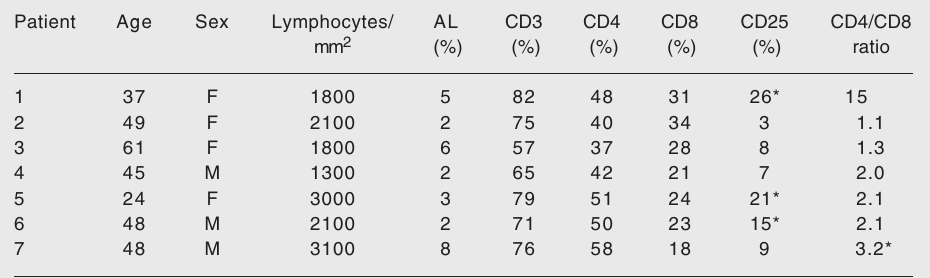
Figure 2. Second, confirmatory PCR for identification of junc- tion segments used in the rear- rangement of the TCR-beta gene. A , Monoclonal rear- rangement was identified in patients 1, 2, 3, and 4, and the joining fragments belong to the Jbeta 1 cluster (segments 1.2, 1.2, 1.2, and 1.2, respectively). B , Patient number 7 presented an oligoclonal pattern of rear- rangement, identified by the three strong bands observed in the lanes labeled 1.1 and 1.2 (in the Jbeta 1 cluster), and 2.5 (in the Jbeta 2 cluster). M = marker of DNA size; bp = base pairs; (+) = positive control; (-) = negative control; N = negative result,